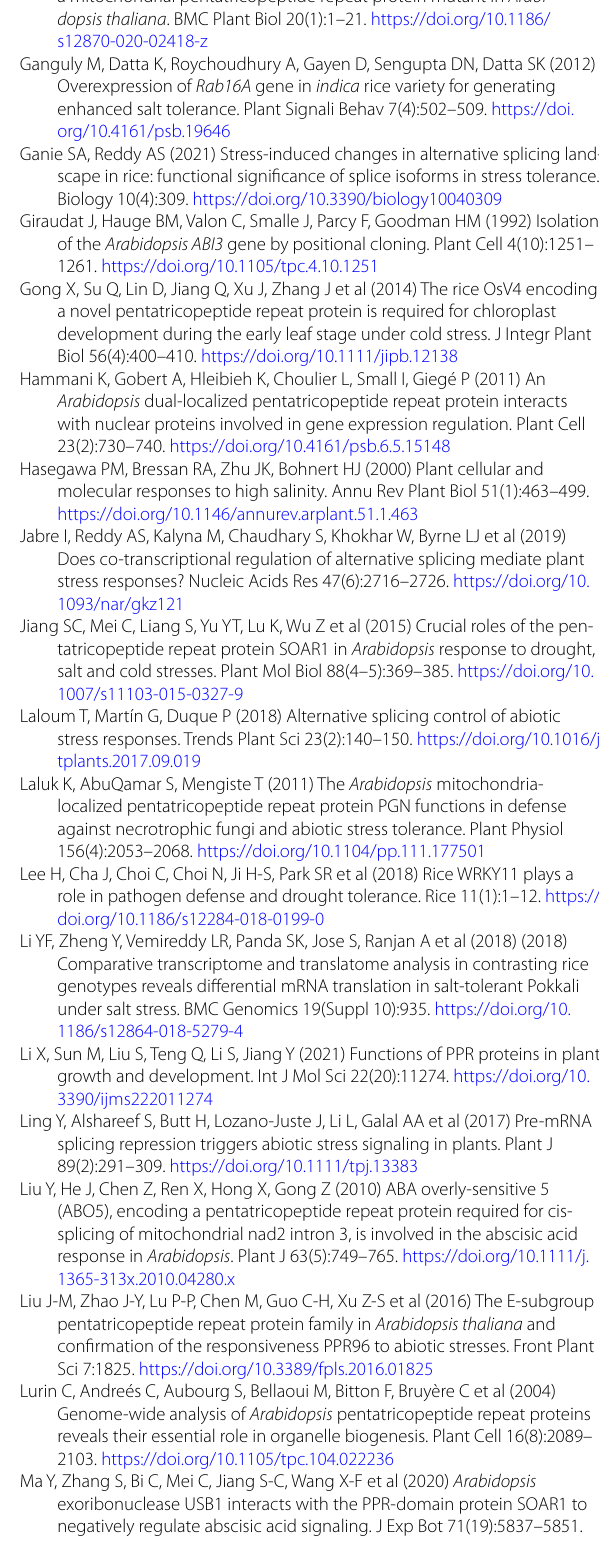
expressed genes between different comparison groups. Fig. S3 : Salt‑induced and SOAR1‑mediated alternative splicing analysis. Fig. S4 : Alignment of coding sequence of AtSOAR1 and OsSOAR1. Fig. S5 : Con‑ firmation of the expression pattern of the five salt‑induced PPR genes by semi‑quantitative RT‑PCR. Fig. S6 : Expression pattern analysis of OsSOAR1 under abiotic stress treatments by qPCR. Table S1 : Summary of the RNA‑ Seq data. Table S2 : List of differential expressed ( genes in SOAR1 expression plants compared with that of wild‑type plants under NaCl treatment by GO analysis. Table S3 : PCR primers used in this study. Additional file 2 . Data 1 : List of differential expressed ( SOAR1 expression plants compared with that of wild‑type plants with or without NaCl